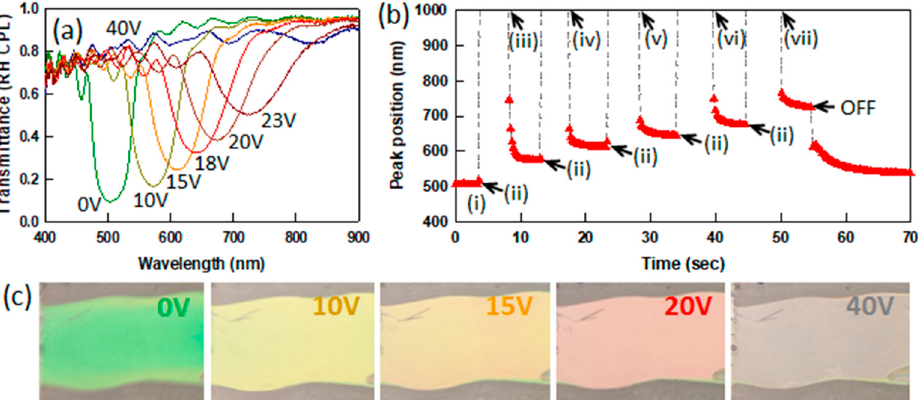
Figure 8. ( a ) Transmission spectra of a negative ∆ε PSCLC with 3 ± 0.2 µm thickness for DC voltages up to 40 V DC. ( b ) Peak position during the switching of the same PSCLC using various DC voltages. The arrows indicate the times at which the DC voltage was changed to the value indicated. ( c ) Photographs of the reflection color of the PSCLC as a function of the applied DC voltage. Adapted from ref. [50].